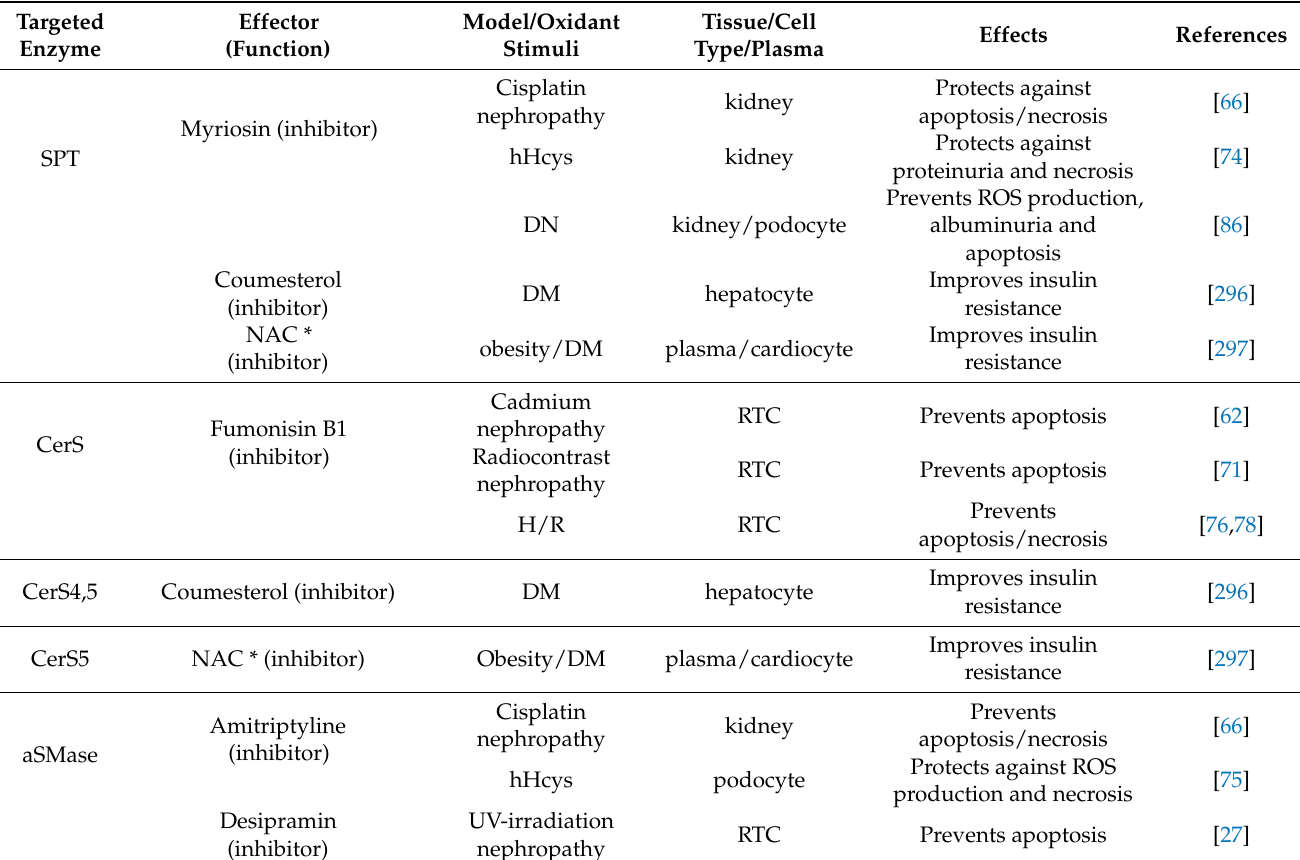
Table 4. Overview of compounds that target the enzymes involved in ceramide and S1P metabolism to improve a ceramide-S1P rheostat, contributing to protection against oxidant-induced kidney